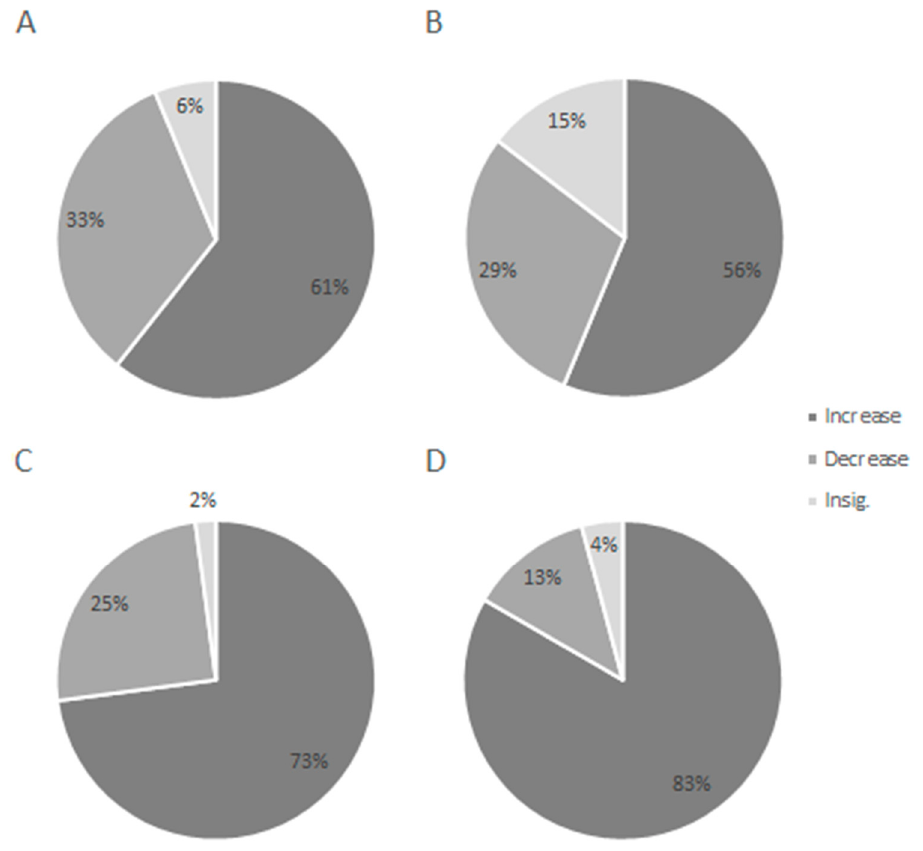
Figure 2. Cardiac response, as percent of recordings showing a significant change in mean heart rate of signal crayfish over 30 min after exposure to stress stimulus compared to the 30 min before stimulus. A = METH exposure, B = METH exposure depuration, C = control exposure, and D = control depuration. Four trials during exposure and four during the depuration period × 12 crayfish = 96 recordings.